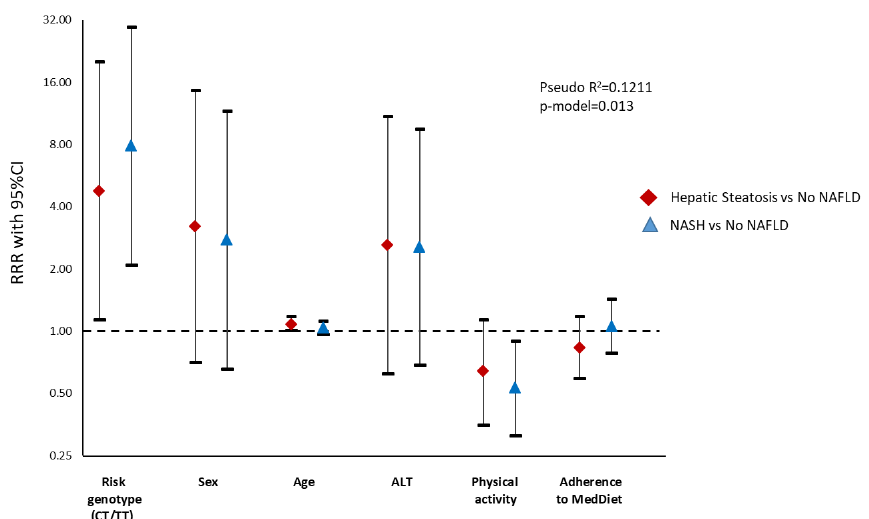
Figure 4. Graphical display of the Relative Risk Ratio (RRR) (95% confidence interval) of the multinomial logistic regression model with SH2B1 genetic variant as an independent variable and the diagnostic of steatosis or steatohepatitis (by lipidomic analysis) as a dependent variable. Notice that the y -axis is on a log scale. ALT, Alanine Aminotransferase; NAFLD: Non-alcoholic Fatty Liver Disease; NASH, Non-alcoholic Steatohepatitis.